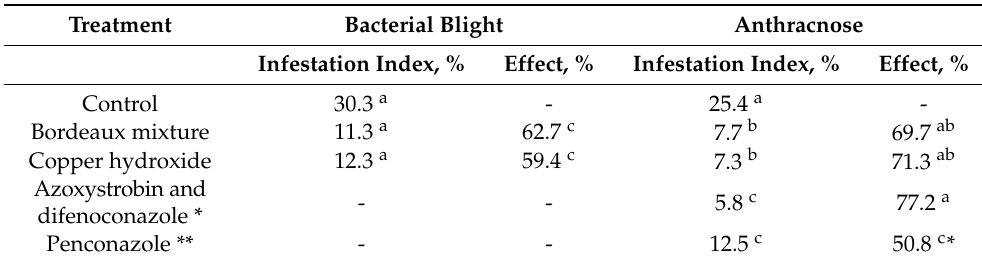
Table 1. Influence of fungicides treatments on bacterial blight and anthracnose development on snap bean. Treatment Bacterial Blight Infestation Index,